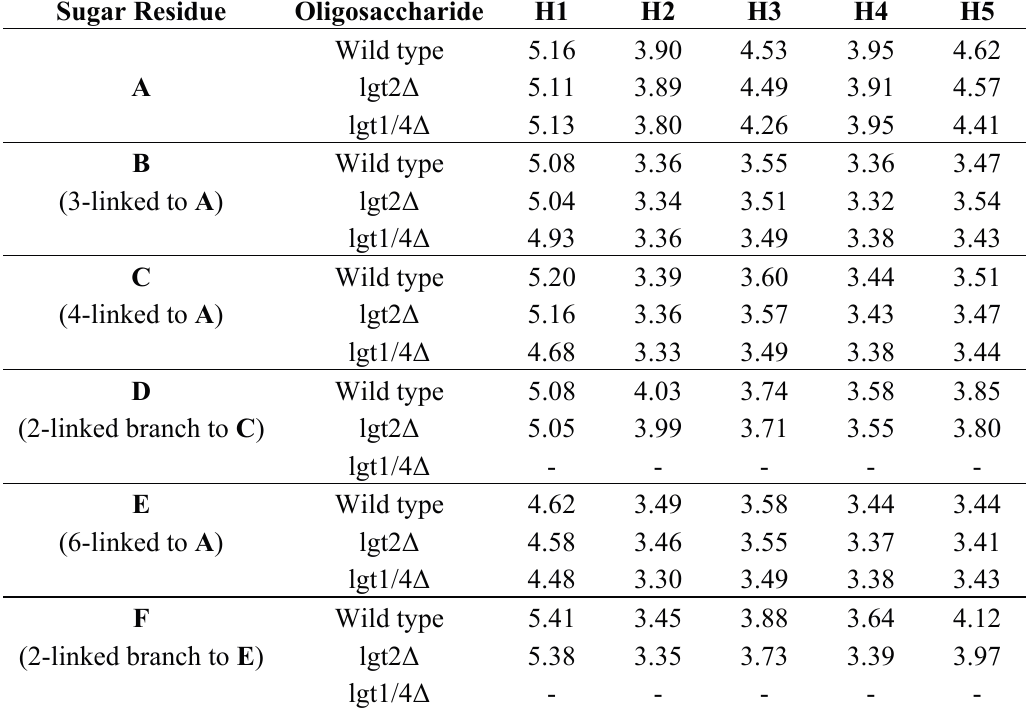
Figure 2. Comparison of the anomeric 1 H-NMR (ppm, D 2 O, 298 K, 600 MHz) regions of serotype A wild type, lgt2 Δ and lgt1/4 Δ OS. Table 1. Comparison of 1 H-NMR data (ppm, D 2 O, 298 K, 600 MHz [15]) for serotype A wild type, lgt2 Δ and lgt1/4 Δ OS (wild type data from Edebrink [12], on serotype A (25238), while lgt2 Δ and lgt1/4 Δ data is from Peak et al. [15] (serotype